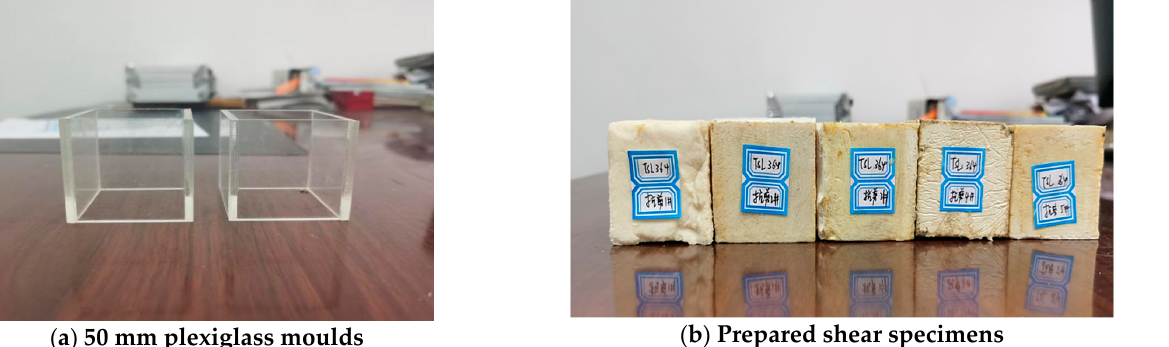
( b ) Shear test process Figure 5. Shear test instrument and process. 2.3. Design of Tensile Test In standard ASTM, the tensile testing sample is a 4 mm thick dog bone. However, in this study, the tensile testing samples were designed as a 20 mm cylinder to investigate the size and distribution of the bubbles generated in the chemical reaction. PVC tubes with inner Φ 30 mm and 200 mm lengths were used to prepare the TSL samples, as shown in Figure 6 a. The dimensions of the clamping end and the test section of the specimen were Φ 30 × 50 mm and Φ2 0 × 100 mm, respectively, as shown in Figure 6b. Six tensile samples were prepared for TSL 1 and 2 materials, but only 3 samples were prepared using MLS. It was found that the MLS samples were loose due to the existence of a huge number of bubbles generated in the chemical reaction, as shown in Figure 6c. In the test, the MLS samples could not be clamped firmly by the testing machine, so only TSL 1 and 2 samples were tested.